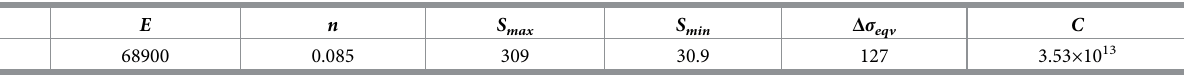
Table 6. Estimated performance parameter values (MPa).